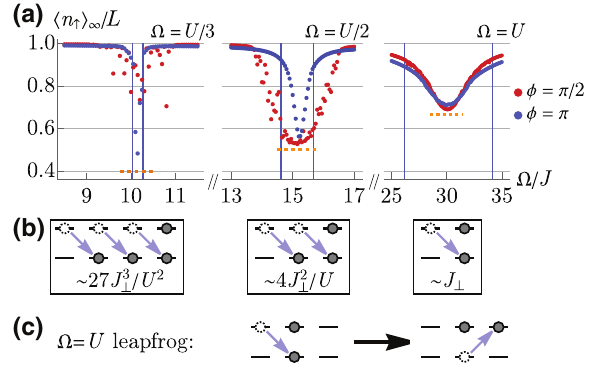
FIG. 4. (a) Long-time average of the population (cid:12)ˆ n ↑ (cid:4) near the resonances (cid:2) = U / 3, U / 2, U for different fluxes φ = π/ 2, π . The system size is L = 11 and the interaction strength is U / J = 30. Time evolution is done out to tJ = 1500, and averaging is done over tJ = 750 to 1500 to avoid the initial population decay. The φ = π resonance widths are set by the respective rates 27 J 3 ⊥ / U 2 , 4 J 2 ⊥ / U , J ⊥ ; the vertical blue lines represent val- ues of ± 4 times the corresponding rate for each resonance. The φ = π/ 2 resonance widths are instead broadened by an effec- tive bandwidth of about J (cid:7) . Note that the specific positions of the resonances are also shifted due to off-resonant superexchange interactions by a factor of the order of about J 2 / U . The orange dashed lines correspond to infinite-temperature thermal average predictions of 2 / 5, 1 / 2, and 2 / 3, respectively (see Appendix C). (b) Associated interaction-enabled tunneling processes for each respective resonance in (a). (c) Leapfrog process by which pairs of ↑ atoms can move at the (cid:2) = U resonance via J ⊥ only.